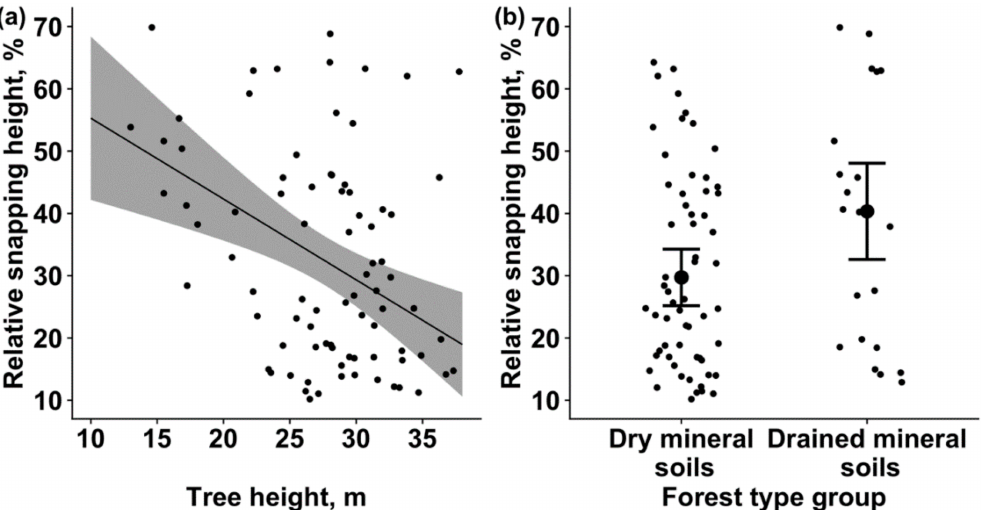
Figure 2. Relative snapping height in relation to tree height ( a ) and forest type group ( b ). The grey area ( a ) and error bars ( b ) represent ± 95% confidence interval. Dry—forest types on dry mineral soil, drained—forest types on drained mineral